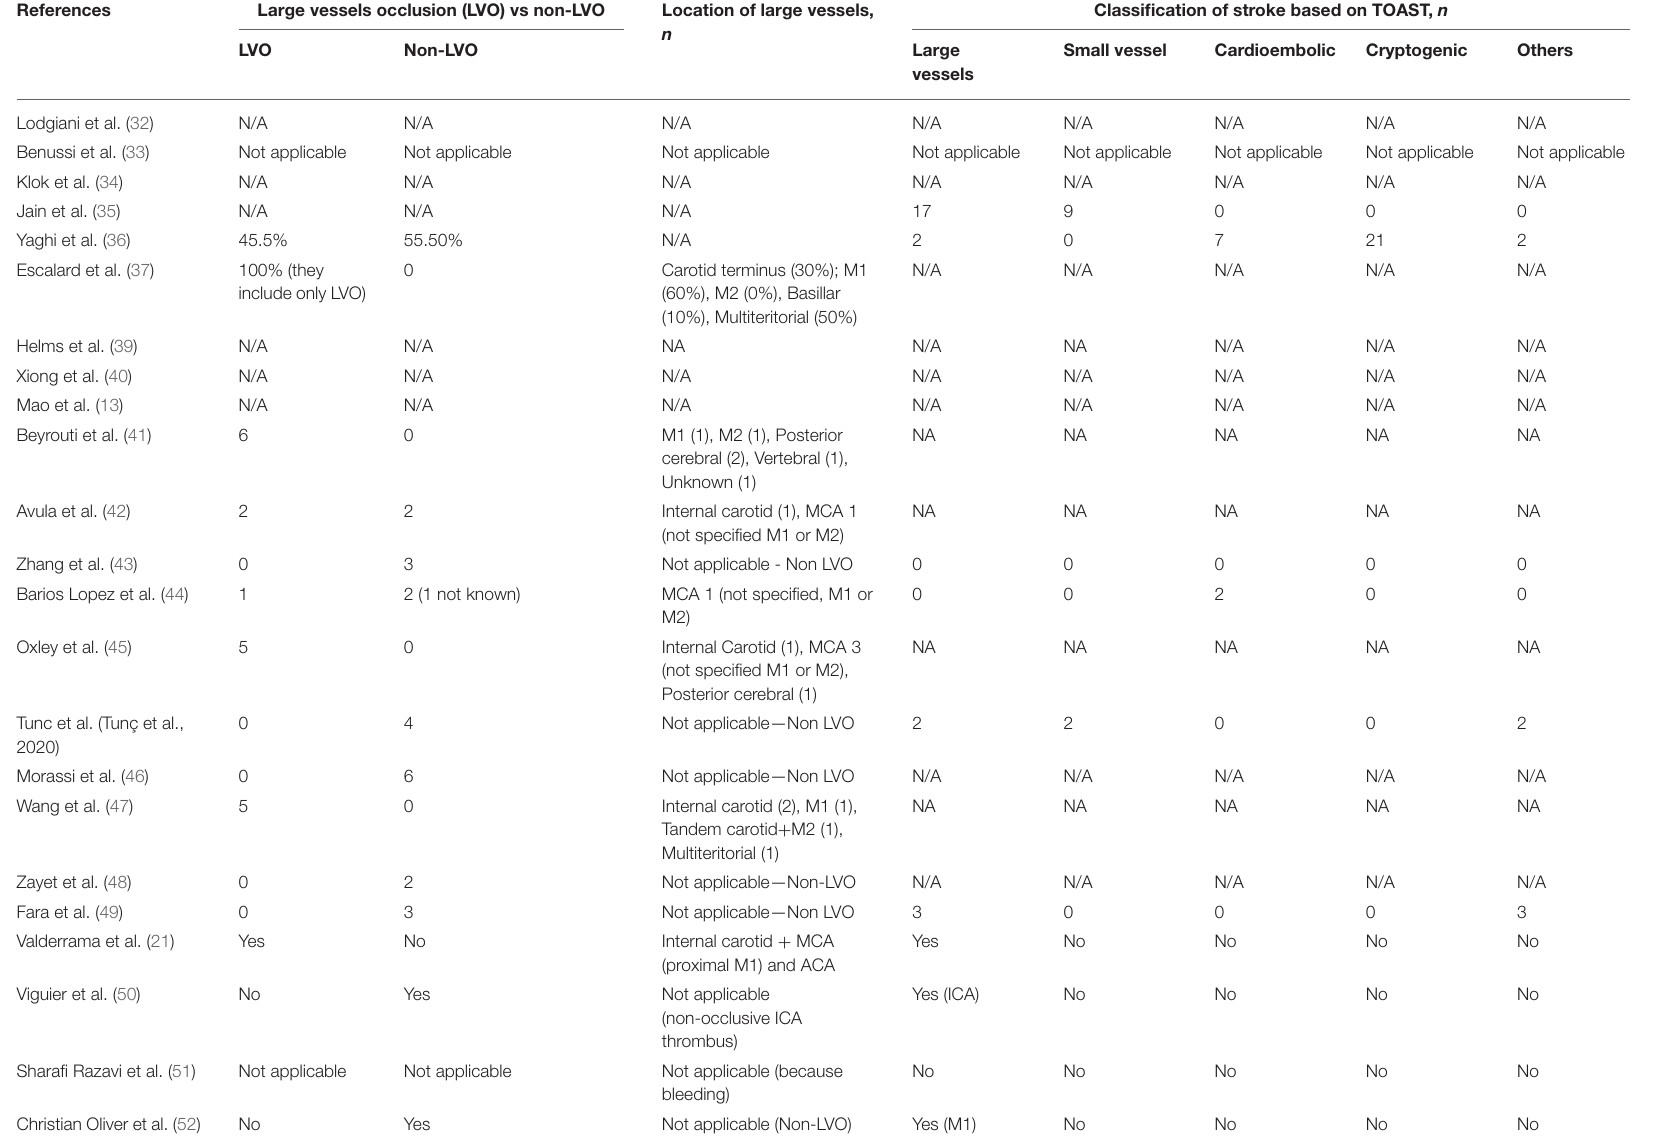
TABLE 4 | Classification of stroke based on vessels occlusion and TOAST in COVID-19